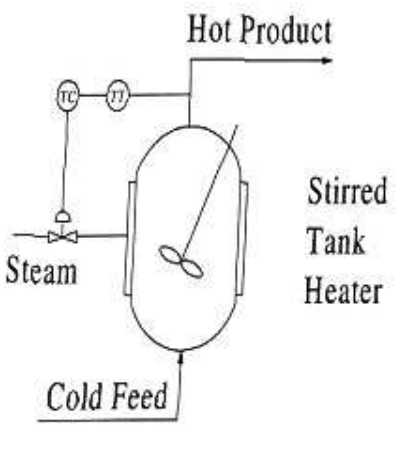
Figure 2. Stirred-tank